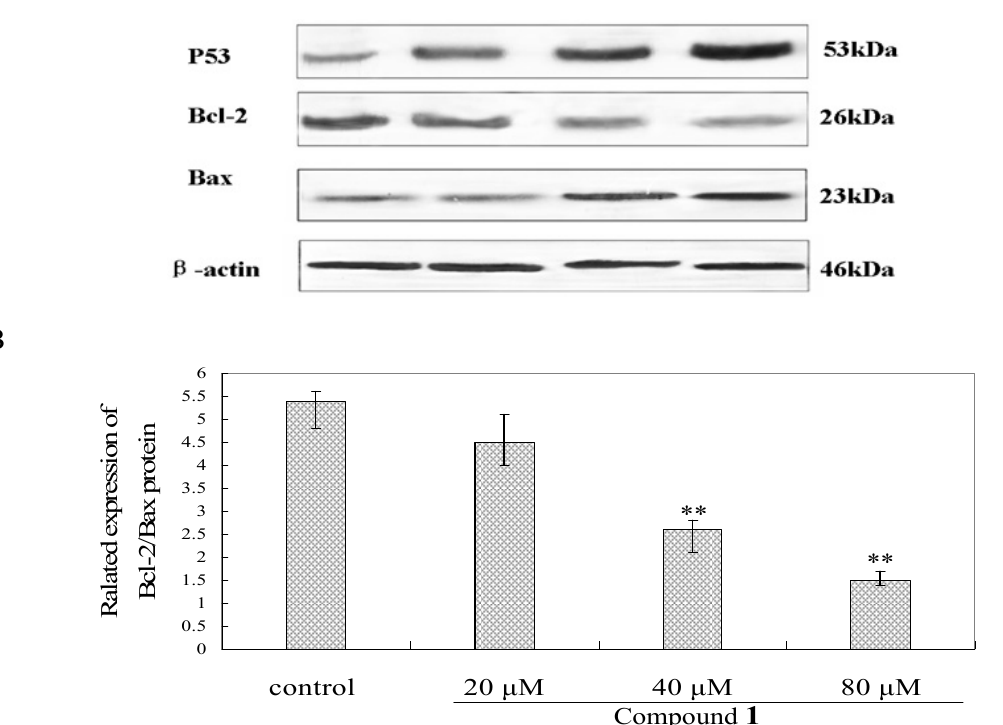
Figure 7. Bel-7402 cells were incubated with compound 1 at the concentrations of 20, 40 and 80 μ M for 48 h, respectively, then, the different proteins levels were measured by westblot method. ( A ) Effects of compound 1 on the expression levels of P53, Bcl-2 and Bax proteins; ( B ) The ratio of Bcl-2/Bax protein expression. ** p < 0.01 as compared to